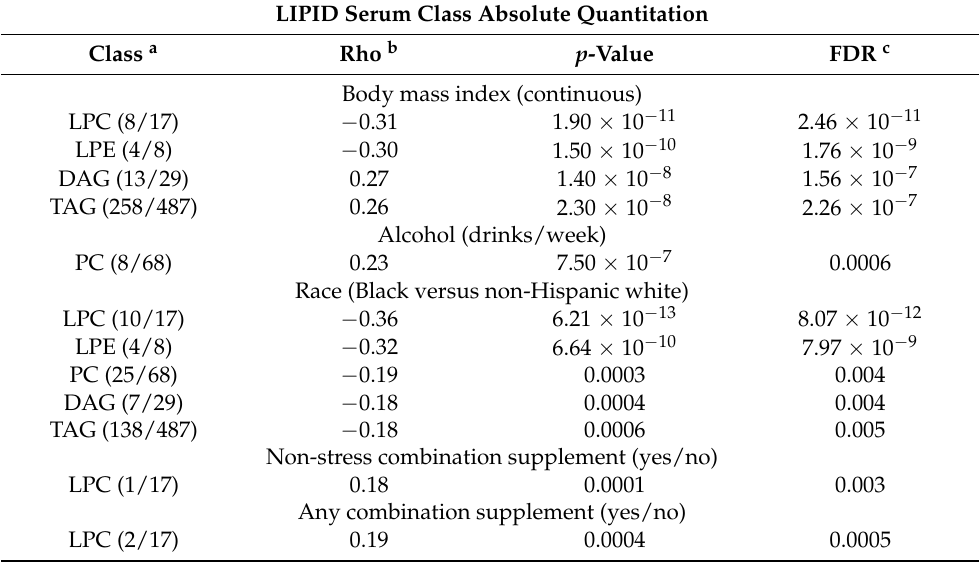
Table 3. Variables correlated with lipids at FDR < 0.01 by lipidomics, descending in level of statistical significance within each